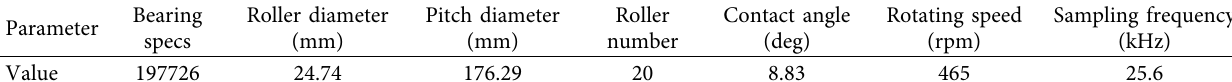
Figure 24: Experiment equipment and the tested bearing of case 2: (a) the experiment bench, (b) an inner-race fault, and (c) an outer-race fault. Table 4: Parameters in the experiment of case 2.